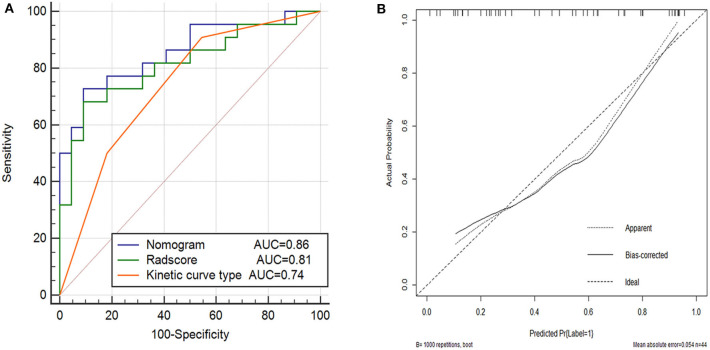
Performance of the kinetic curve pattern, the Radscore and the nomogram model on external validation cohort. (A) Receiver operating characteristic curve for the three models with AUCs of 0.74, 0.81, and 0.86, respectively. (B) Calibration curve of the nomogram model in the validation cohort.